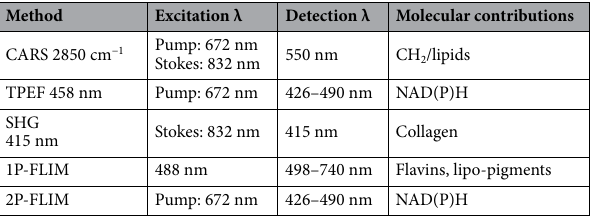
Table 1. Summary of multimodal optical modalities emphasizing molecular contributions detected in tissue 35,40,41,56,67